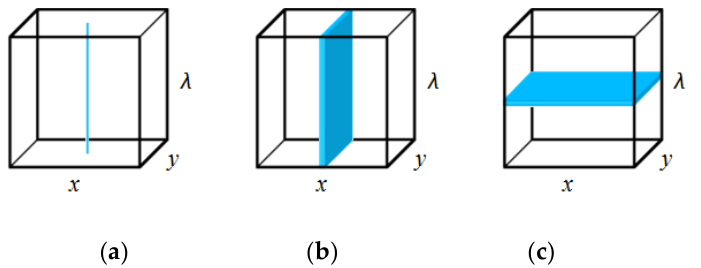
Figure 5. Methods of spectral image acquisitions with ( a ) point scan, ( b ) line scan, and ( c ) area scan [35]. Reproduced with permission from J. Qin, Journal of Food Engineering, Published by Elsevier, 2013.